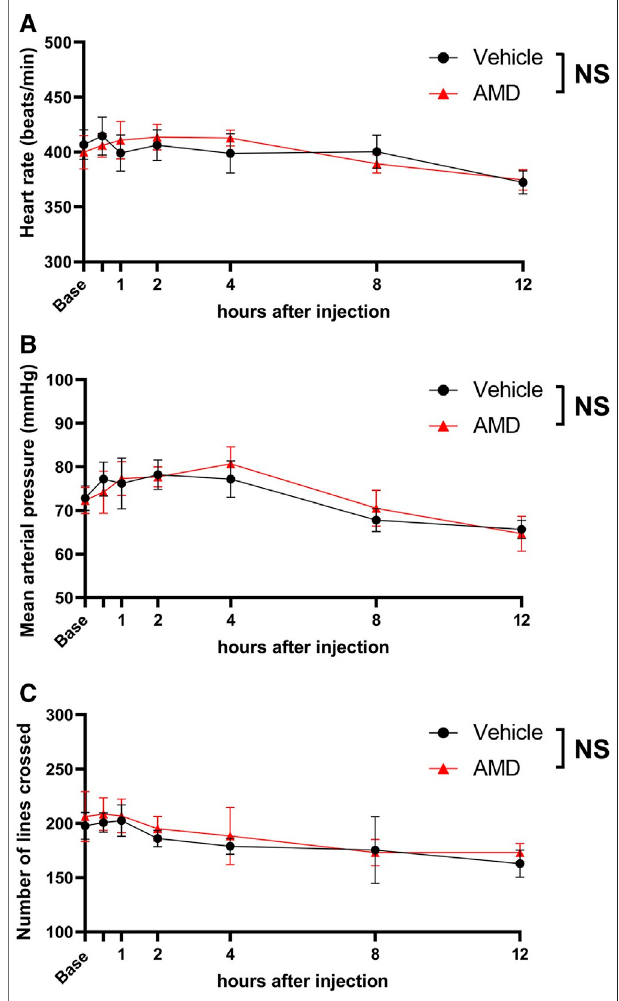
FIGURE 3 | Assessment of cardiovascular and neurological effects by localamiodarone. (A) Heartratemeasuredusingthree-probeelectrogram. (B) Noninvasive mean arterial blood pressure measured using the tail-cuff method. (C) Spontaneous activity after zymosan injection assessed usingtheopen- fi eldtest.Thenumberoflinescrossedwithallpawsduringa5- min period was counted. AMD: